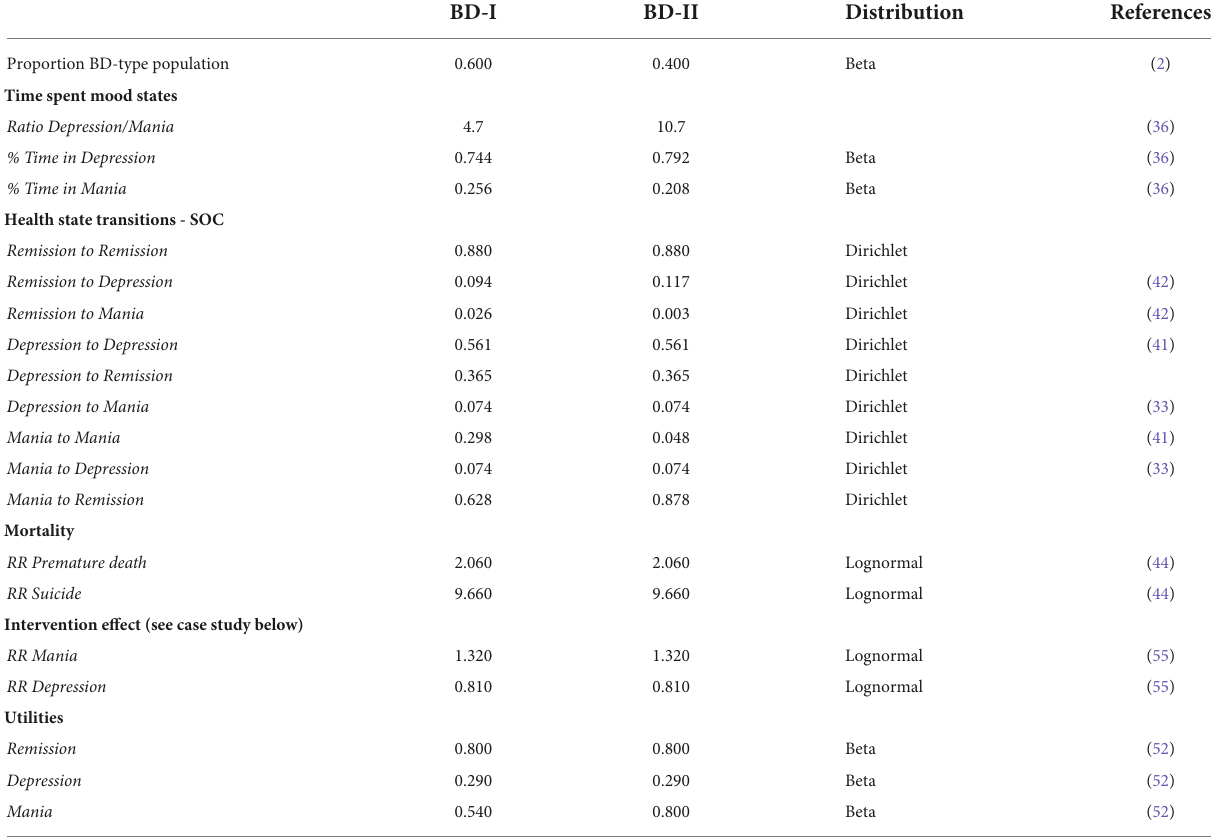
TABLE 1 TiBipoMod state transition probabilities per (three-month) cycle and health state utilities. BD-I BD-II